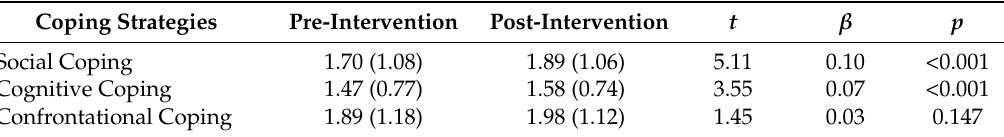
Table 3. Coping strategies before and after the